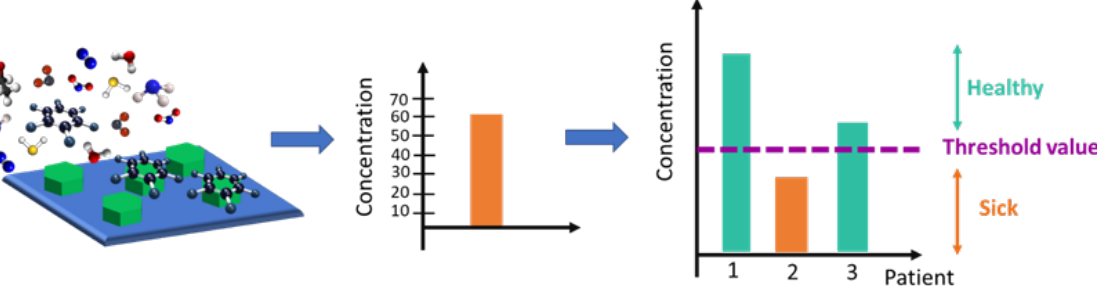
Figure 1. Schematic representation of the working principle of a highly selective sensor. The selective sensor has been properly functionalized with the aim of recognizing and detecting a specific gas-analyte among the interfering gases present in the exhaled breath. After the exposure, the sensor response is evaluated and linked to a specific concentration of the gas-analyte in the breath; finally, the obtained concentration value is compared with a threshold value, which leads to the discrimination between sick and healthy subjects.